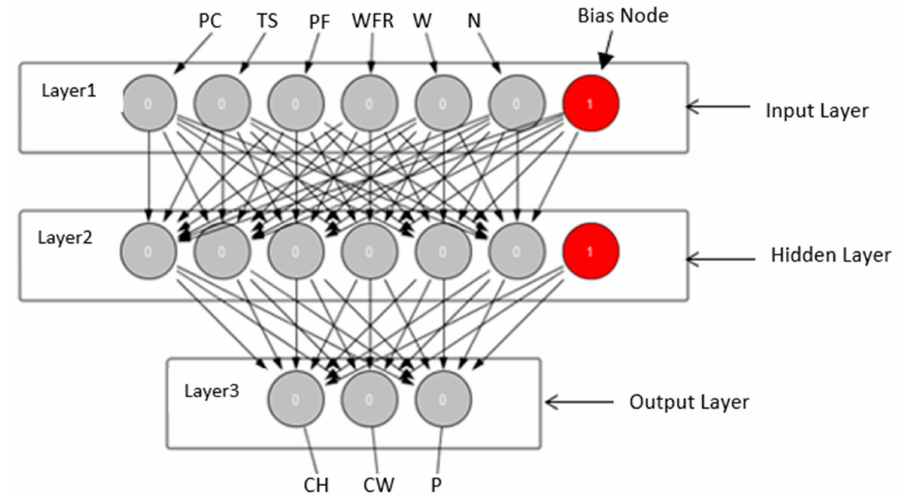
Figure 2. Neural Network used for the prediction of bead